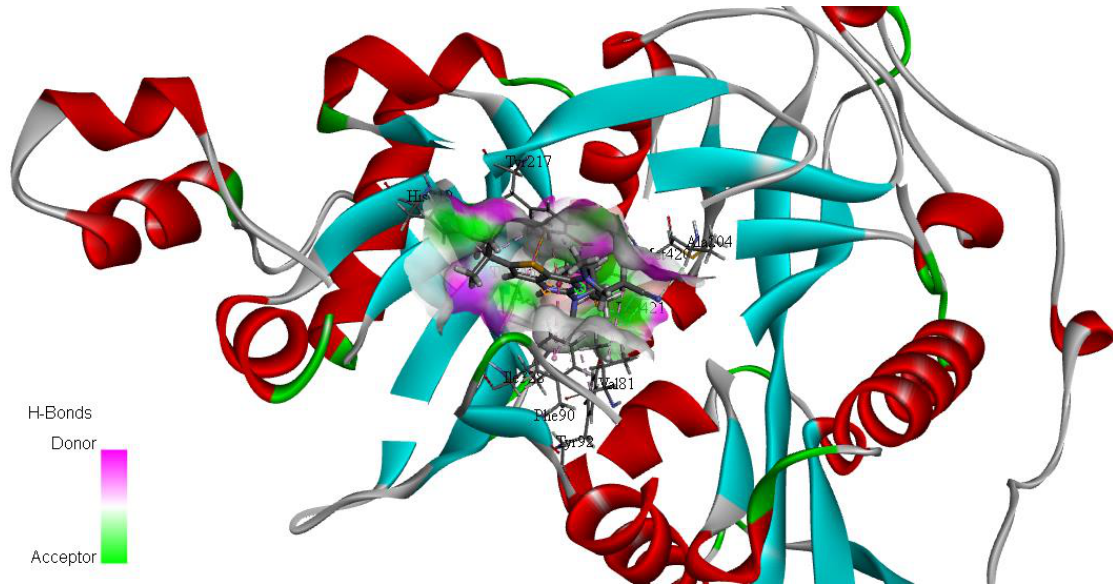
Figure 3. 3D structure of L. major NMT in complex with the thienopyrimidine inhibitor IMP-0000096 (PDB ID: